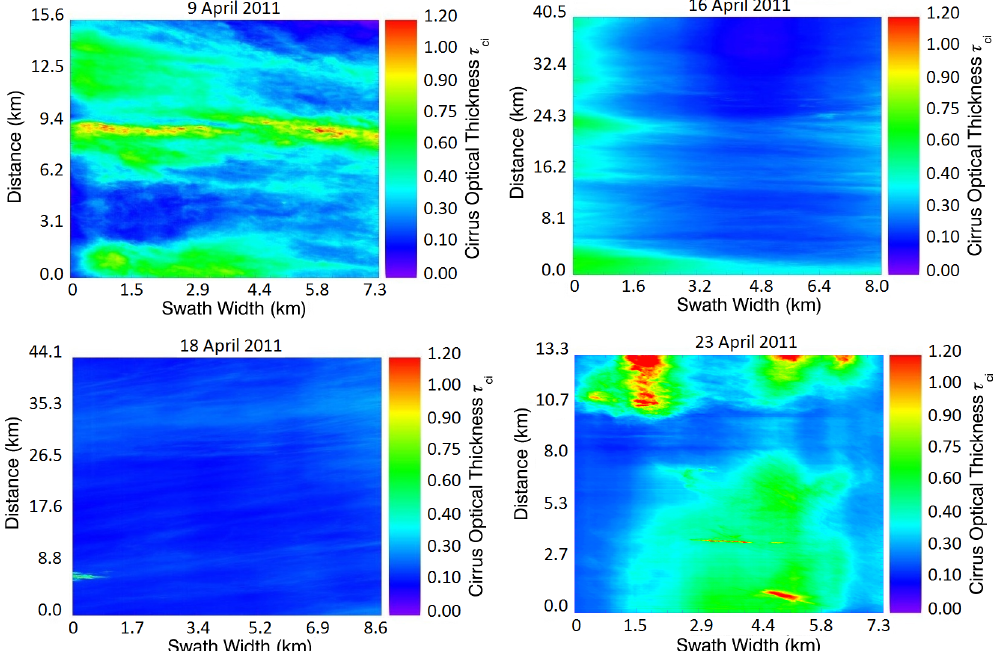
Fig. 13. Time series of the retrieved τ ci during the four measurement cases for each spatial pixel. Abscissa and ordinate values are different due to different measurement conditions.